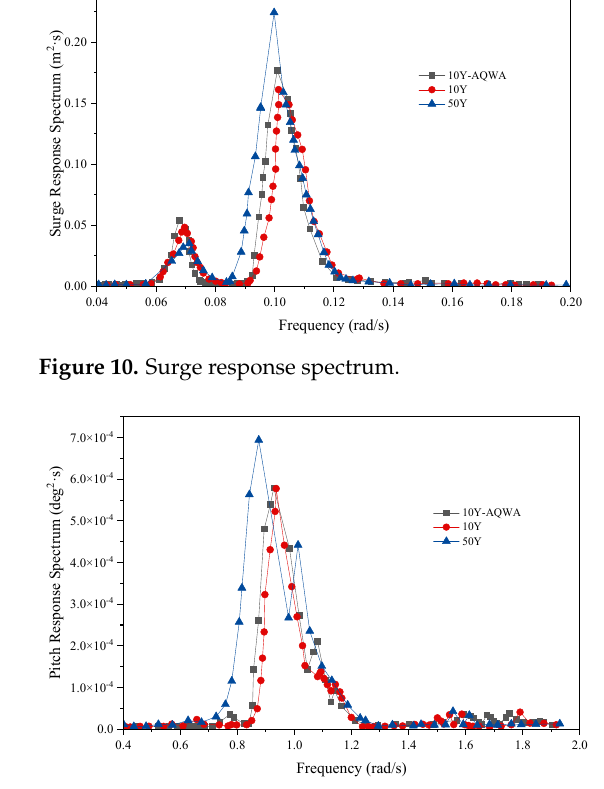
Figure 9. Pitch motion of TLP under different wave heights.